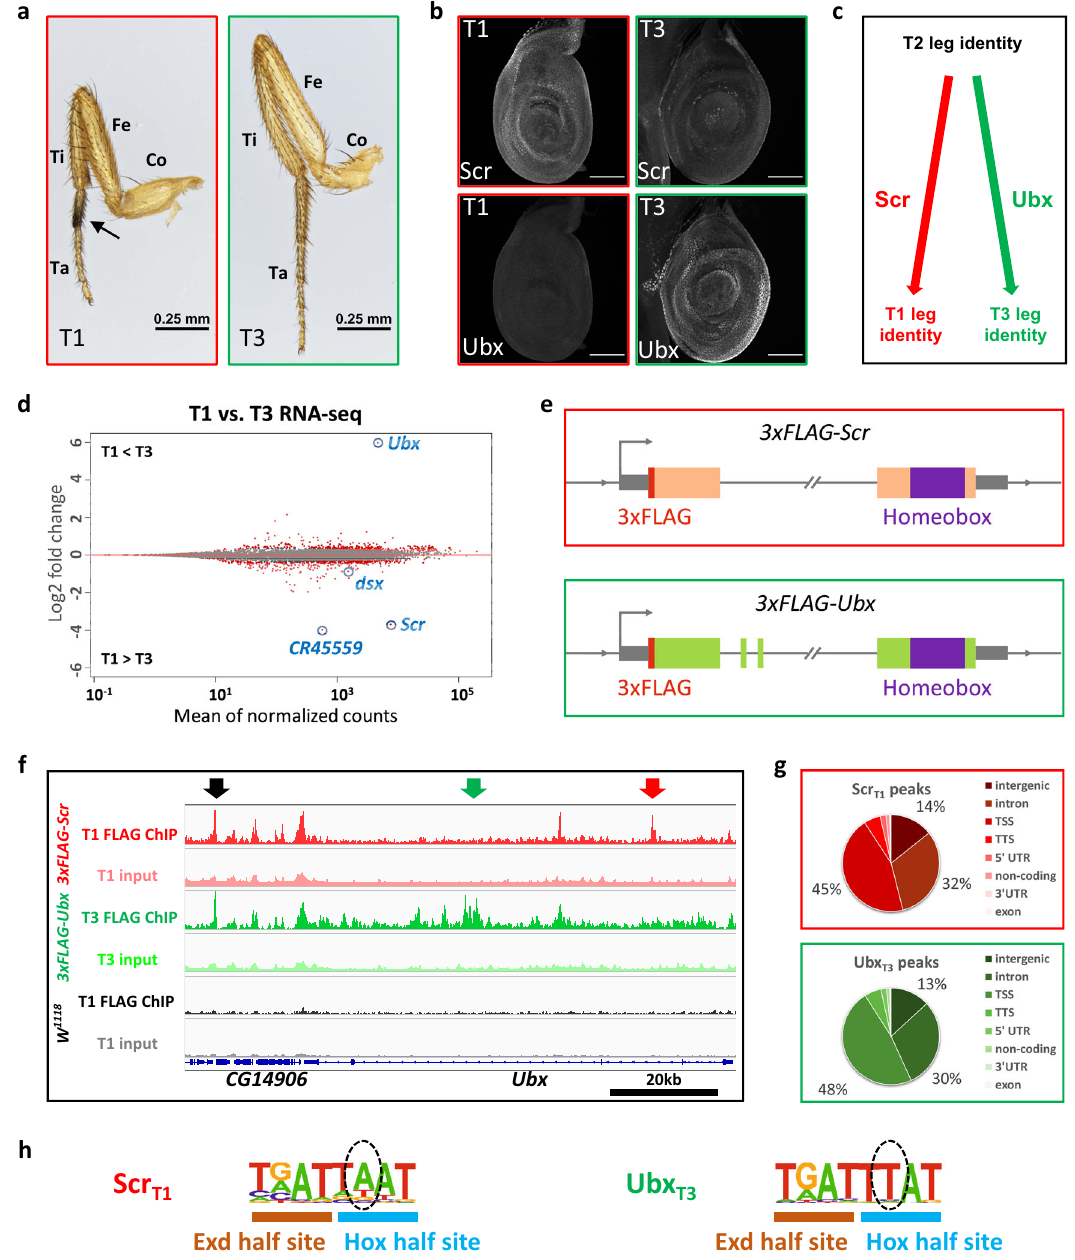
Fig. 1 Genome-wide Scr and Ubx ChIP-seq and transcriptomes from T1 and T3 leg discs. a Medial view of T1 and T3 legs from adult males. Co coxa, Fe femur, Ti tibia, Ta tarsus. Compared to T3, T1 legs have larger coxa and shorter femurs and, in males, have a tightly packed row of specialized bristles called sex combs on the fi rst tarsal segment (arrow). b Co-immunostaining of Scr and Ubx proteins in T1 and T3 leg discs in the wandering larva stage. Weak Scr signal in T3 leg disc is from adepithelial cells 1 . Scale bar: 100 μ m. c Summary of Scr and Ubx functions in specifying T1 and T3 leg identities, respectively. d MA plot comparing the T1 and T3 leg disc transcriptomes. Differentially expressed genes (FDR < 0.01) are labeled red. Several genes investigated in this study are indicated. CR45559 is a lincRNA near the Scr locus. e Schematics (not to scale) of the 3xFLAG-tagged Scr and Ubx alleles generated by genome targeting ( “ Methods ” ) 2 . The wide boxes ( Scr , orange; Ubx , green) indicate coding regions; the homeobox is purple and N-terminal 3xFLAG tags is red. The gray boxes are UTRs. The double-slash denotes large introns. The direction of transcription is indicated by an arrow at the transcription start site (TSS). f Genome browser view near the Ubx locus showing anti-FLAG ChIP-seq data from T1 or T3 leg discs dissected from isogenic stocks containing the 3xFLAG-Scr, 3xFLAG-Ubx , or no FLAG -tagged allele ( w 1118 ). Arrows indicate examples of different classes of binding: red: Scr green: Scr T1 < Ubx T3 . g Pie graphs showing the genomic classi fi cation of Scr and Ubx ChIP-seq peaks. TSS: transcription start site (promoter), de fi ned as -1 kb to + 100 bp from the + 1 nucleotide of mRNA. TTS transcription termination site. h Hox – Exd-binding motifs are the most signi fi cantly enriched motifs in Scr T1 and Ubx T3 peaks located in intergenic regions or introns (see Supplementary Fig. 3a for complete lists). Hox and Exd half-sites are indicated. Dashed ovals indicate positions that are known to differ for Scr-Exd and Ubx-Exd 3